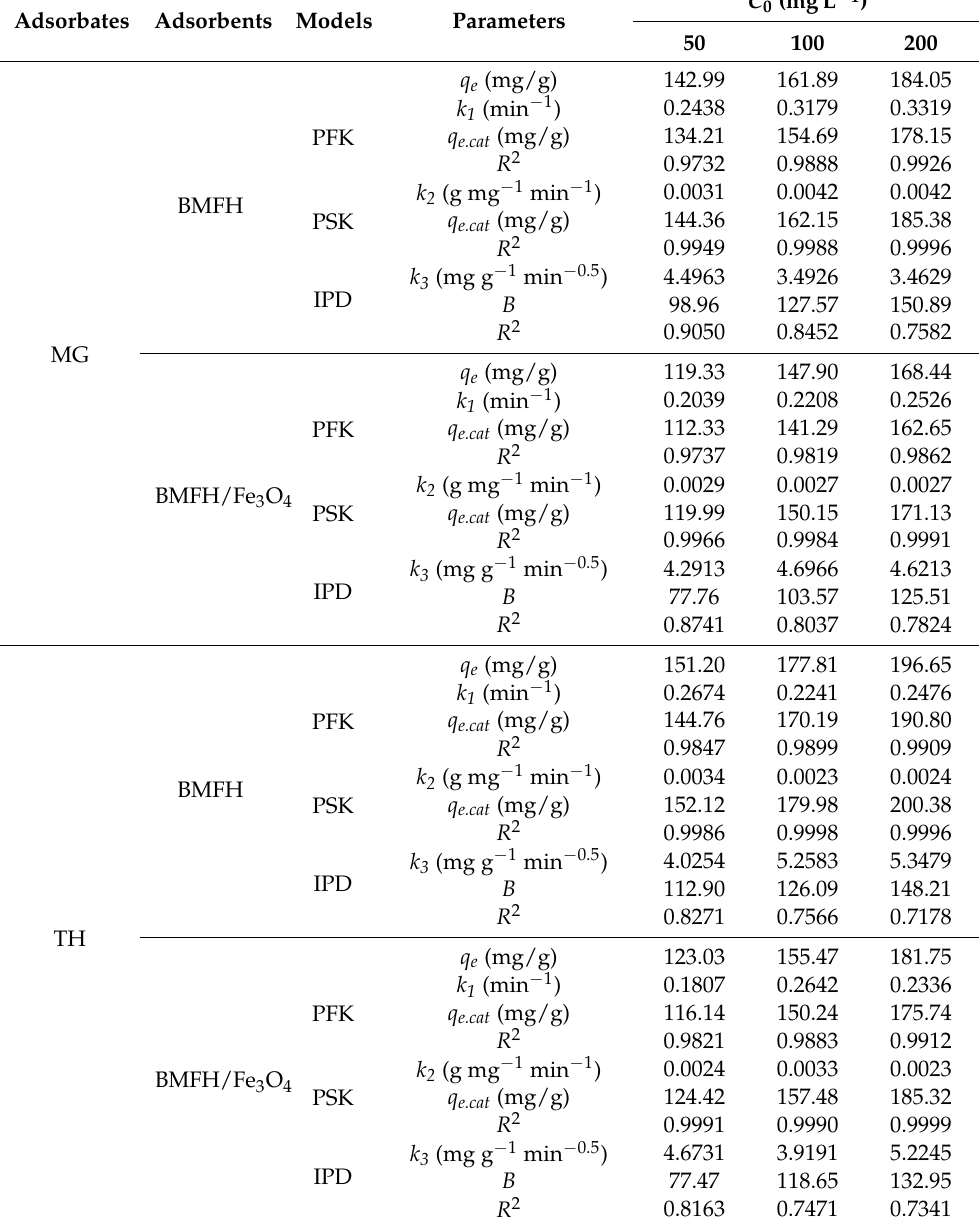
Table 2. Fitting parameters of adsorption kinetic models for MG and TH at 303 K. Adsorbates Adsorbents